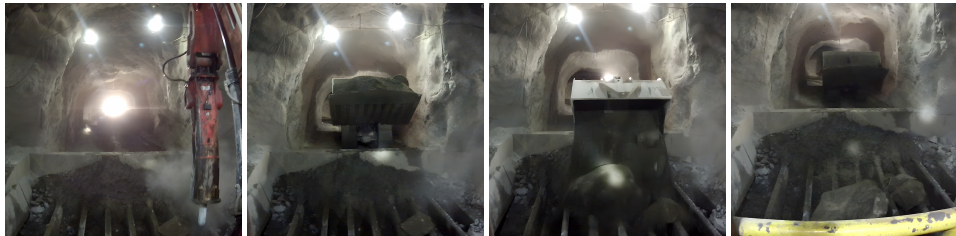
Figure 1. Interaction between an LHD dumping material onto the grizzly, and a hydraulic impact hammer. When the LHD is approaching the grizzly, the impact hammer moves to a safe